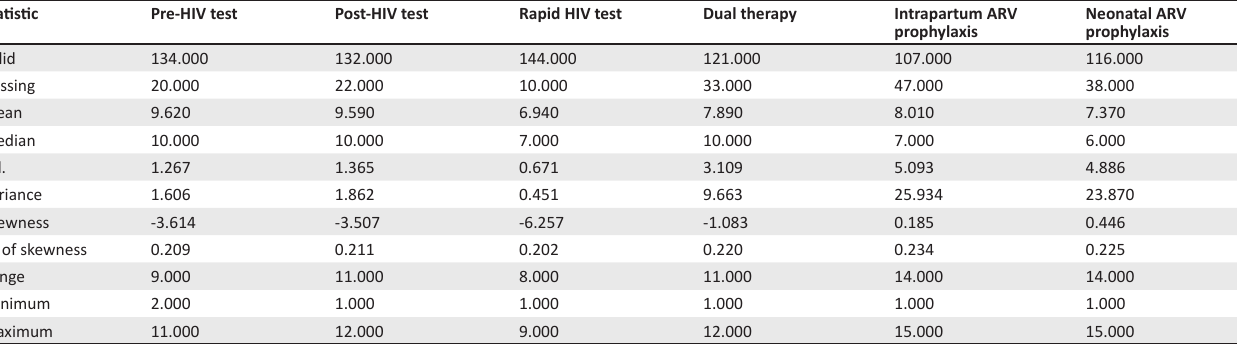
TABLE 2: The statistical analysis showing mean and standard deviation of all students’ performances on prevention of mother-to-child HIV transmission competencies. Statistic Pre-HIV test